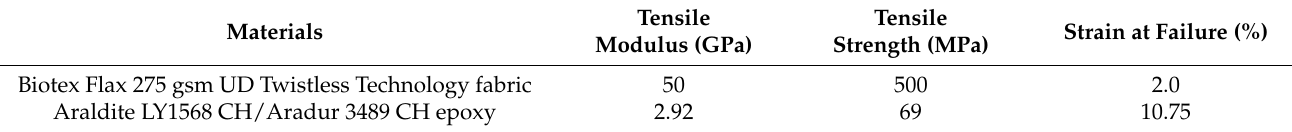
Table 2. Modulus, strength and strain to failure of the reinforcement and matrix [43,44].